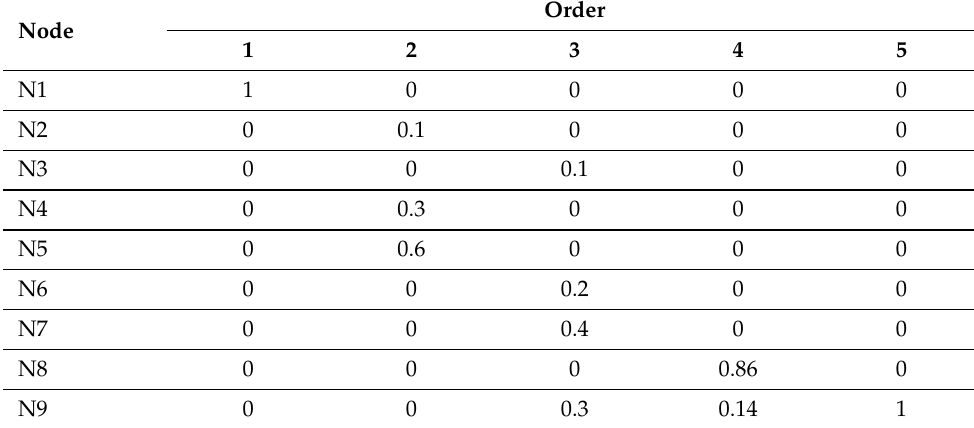
Table 4. Emission matrix (B).